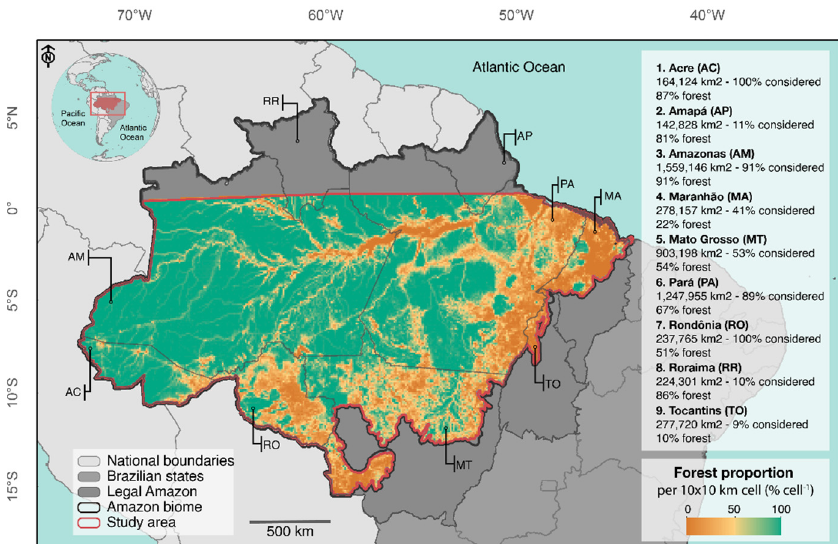
Figure 1. Study area located in the Legal Amazon. Forest proportion in a 10 × 10 km grid cell, extracted by the Amazon Forest Deforestation Calculation Program (PRODES) forest mask of 2016 used to select burned areas over the forest. It presented the total area of each Brazilian state that intersects the study area, and their respective percentage area and forest area within the considered